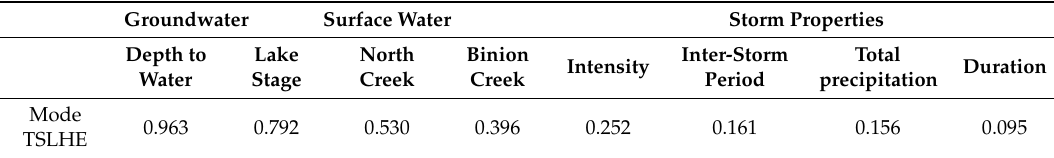
Table 1. The mode of the TSLHEs for each of the distributions. The North and Binion Creek values represent stream discharge series.